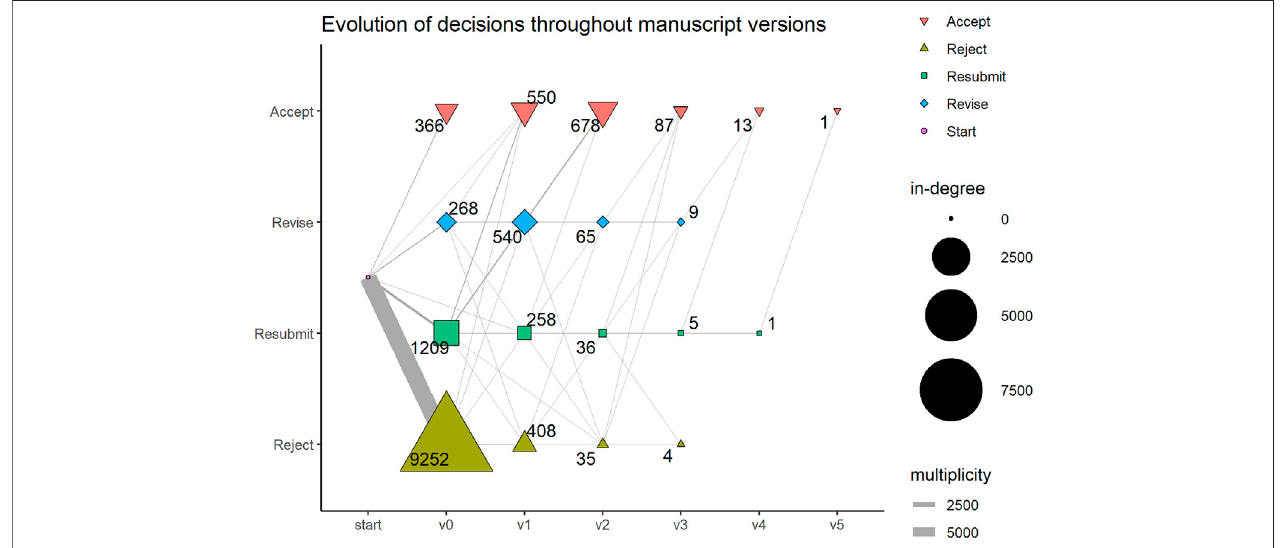
FIGURE 1 | The fi gure shows the decisions for the original manuscript version (v0) and resubmitted versions (v1 – v5). The numbers indicate, how often a speci fi c decision is reached for the respective version (the in-degree of the node). The edge widths show, how many manuscripts experience the respective evolutionary path.